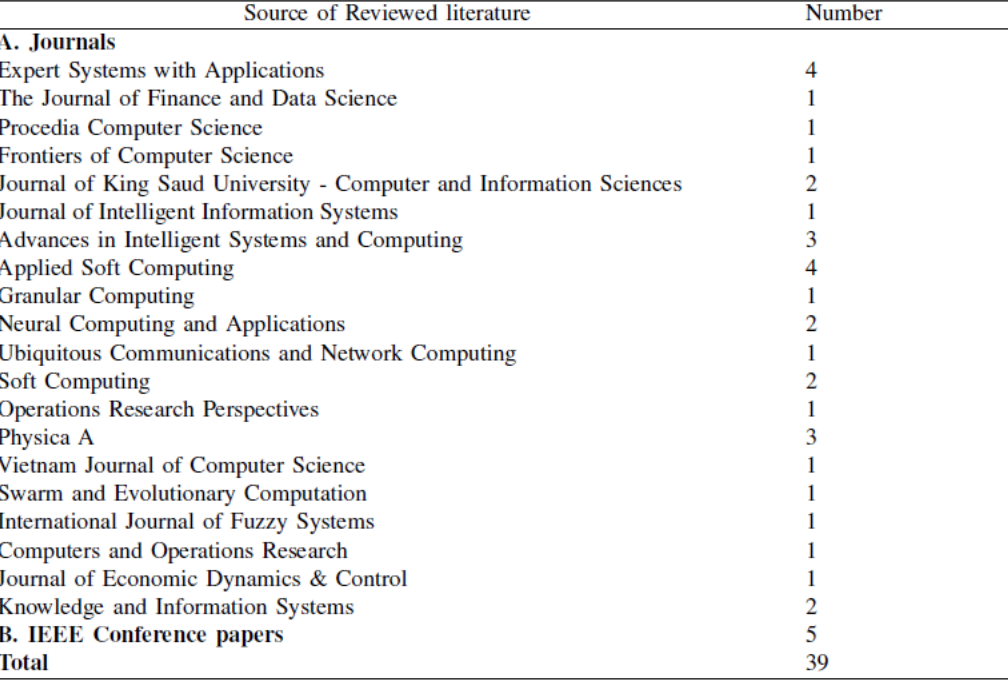
Figure 3. Sources of reviewed research